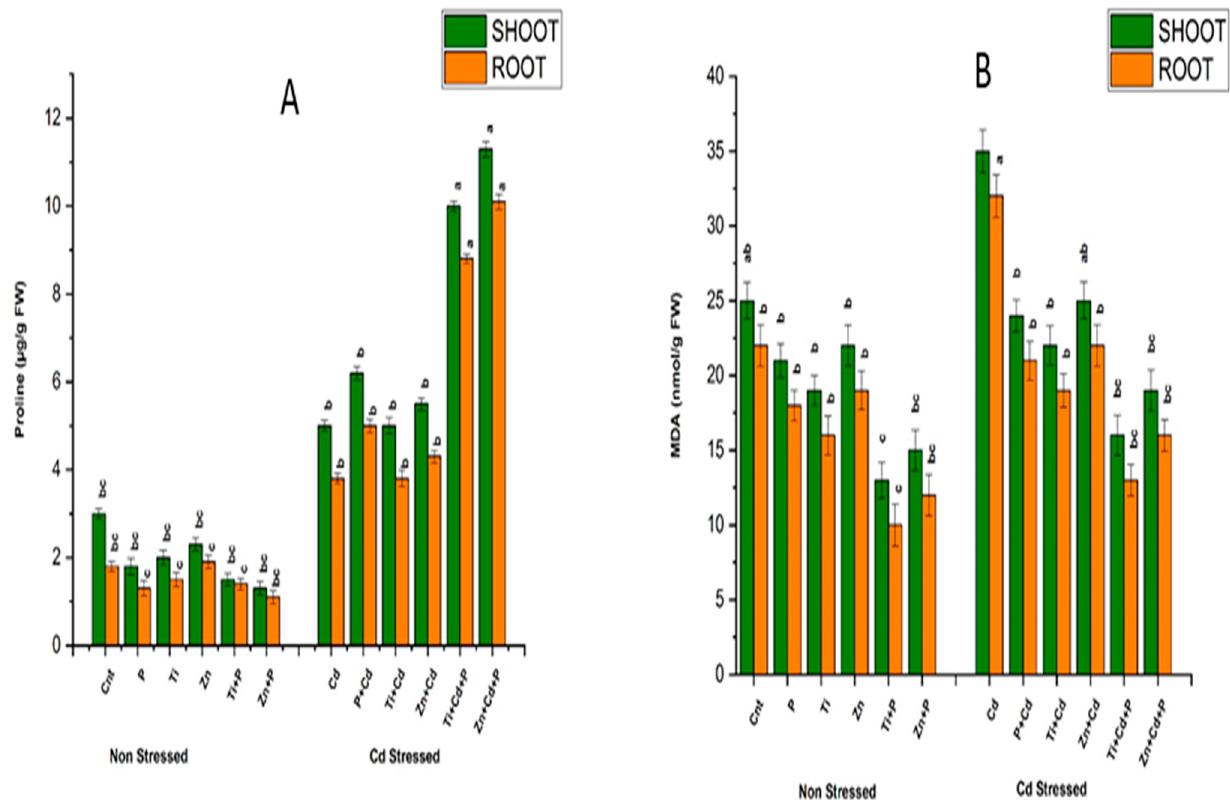
Figure 2. Effects of sole and combined treatments of plant-growth-promoting bacteria (PGPB) ( Bacillus pumilus ), zinc oxide, and titanium dioxide nanoparticles on ( A ) proline content ( B ) MDA content. To compare different mean values of all treatments, the least significant difference (LSD) was computed at p = 0.05.